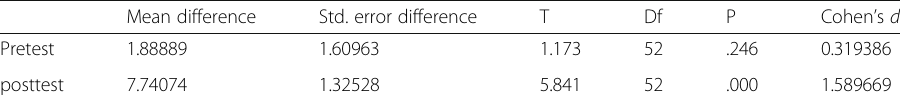
Table 9 Independent samples t-tests on MRQ before and after treatment Mean difference Std. error difference T Df P Cohen ’ s d